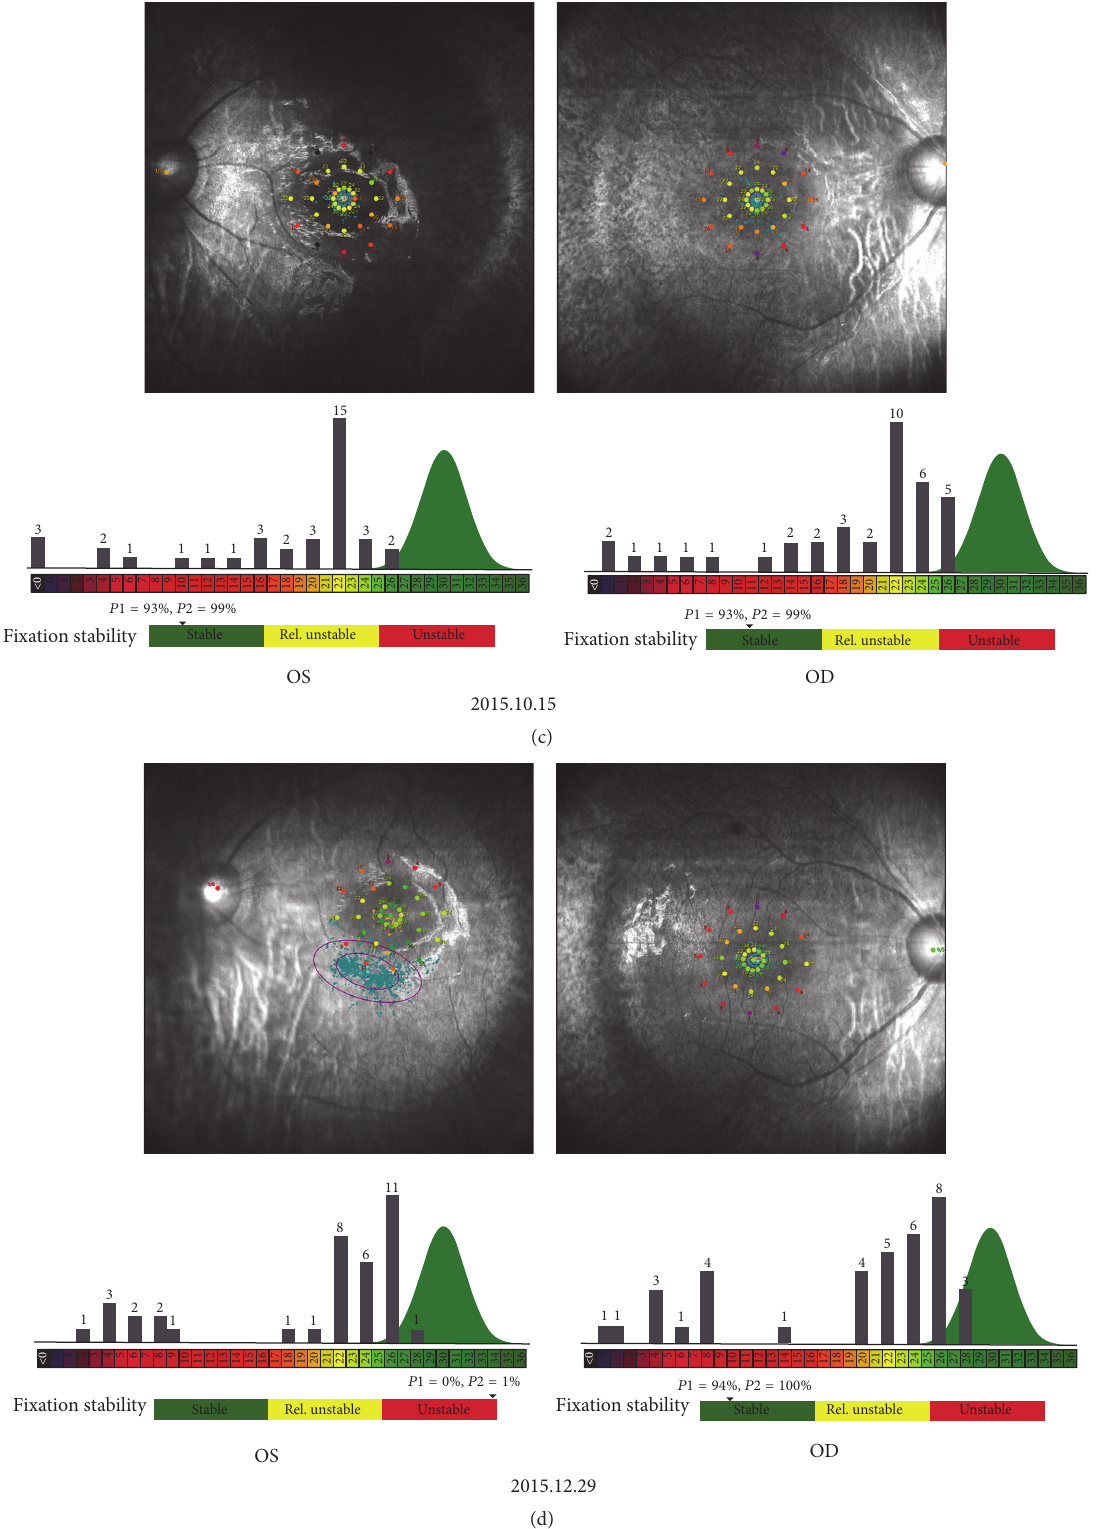
Figure 4: The Goldmann visual field of both eyes (a) shows the defect in all regions except the upper nasal quadrant of the right eye, on Oct. 15; (b) shows a diffuse improvement of the light sensitivity in the central visual field, on Dec. 29. The macular microvisual field of both eyes (c) shows the greatly damaged central visual field on Oct. 15; (d) shows an improved central visual field on Dec.